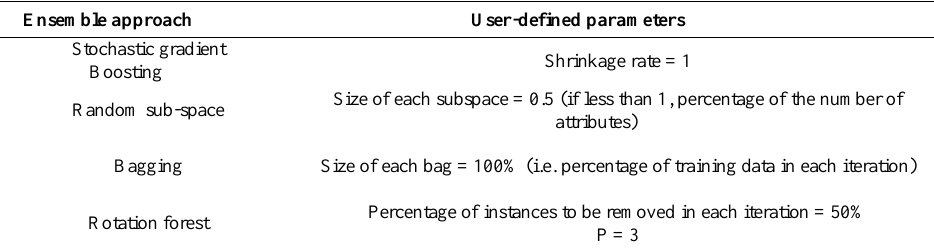
Table 4. User-defined parameters for different ensemble